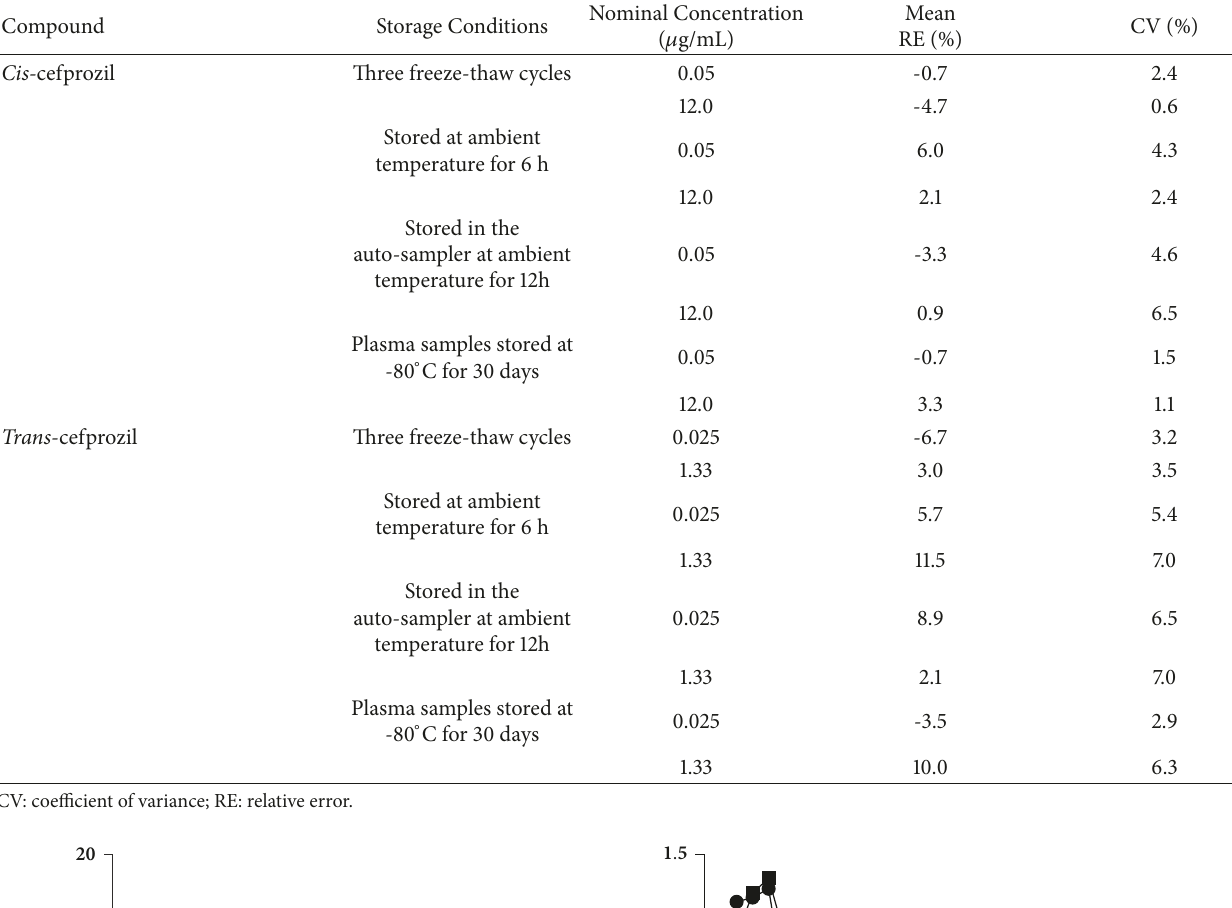
Table 3: Stability of cis - and trans -cefprozil in human plasma under different storage conditions ( n = 3). Compound